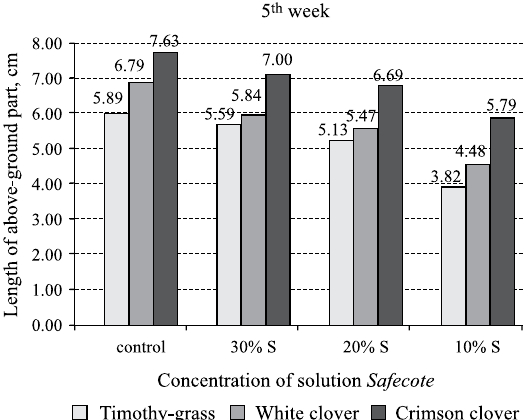
Fig. 8. Length of above-ground part of grass vegetation after 6 th week of